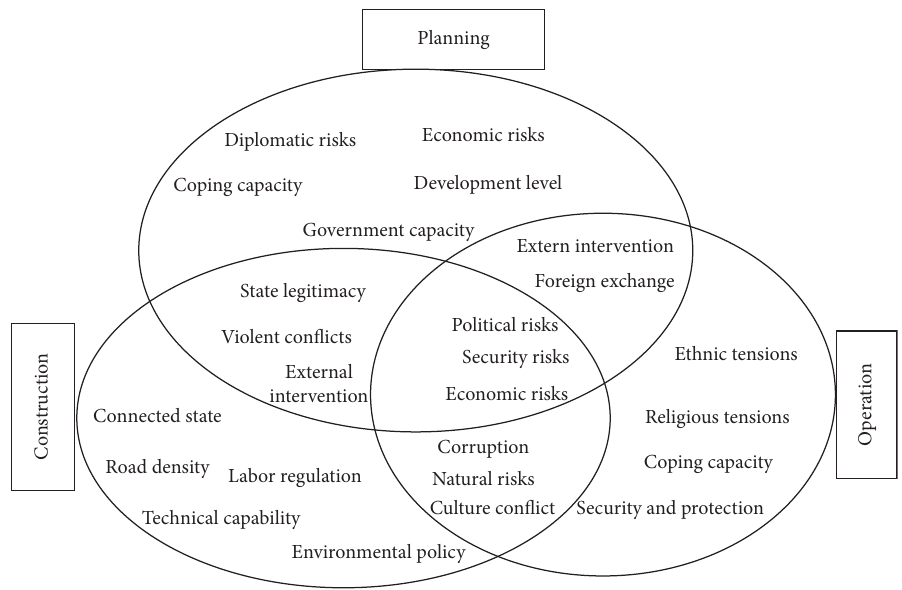
Figure 3: The risks during different periods of